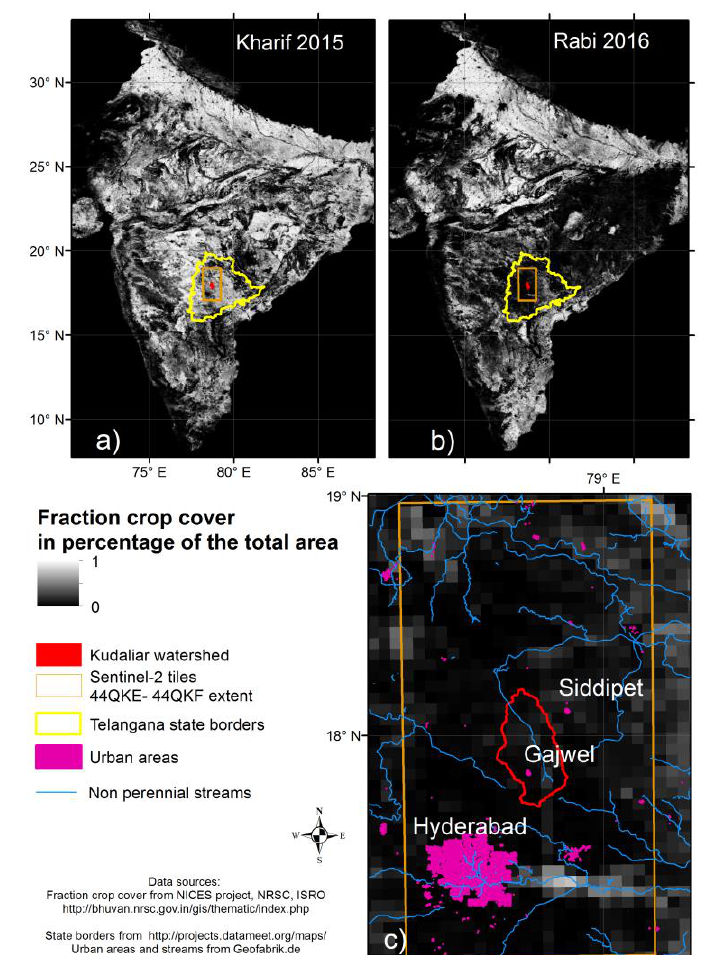
Figure 1. Location of the study area in Telangana State, South India. The Kudaliar watershed area is embedded in two Sentinel-2 tiles (orange outline). ( a ) Fraction crop cover in wet Kharif season 2015 (July to November); ( b ) Fraction crop cover in dry Rabi season 2016 (December 2015 to March 2016); ( c ) Fraction crop cover for the study area in Rabi 2016. This product is provided at 5 km resolution from optical remote sensing at 56 m resolution.